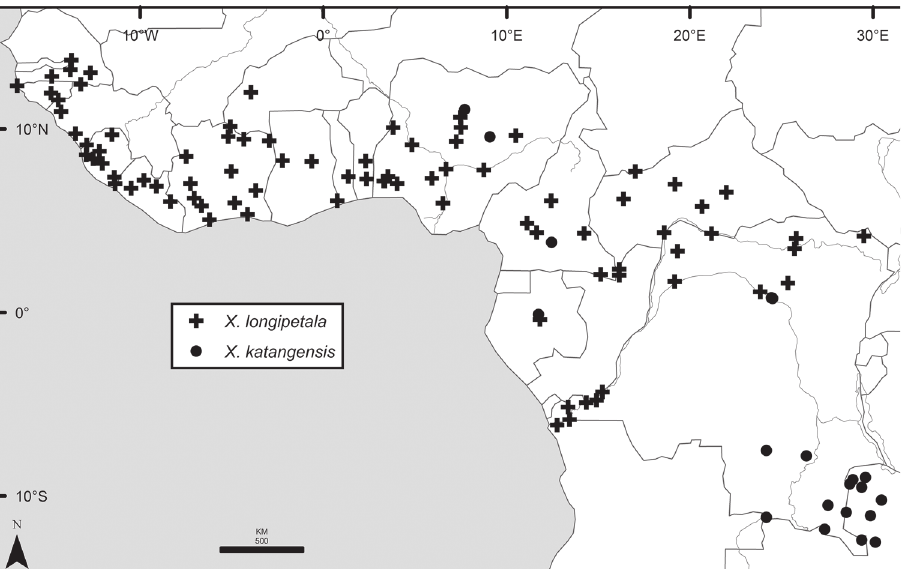
Figure 45. Distributions of Xylopia longipetala and X. katangensis . Bolder lines represent country borders, fainter lines lakes and major